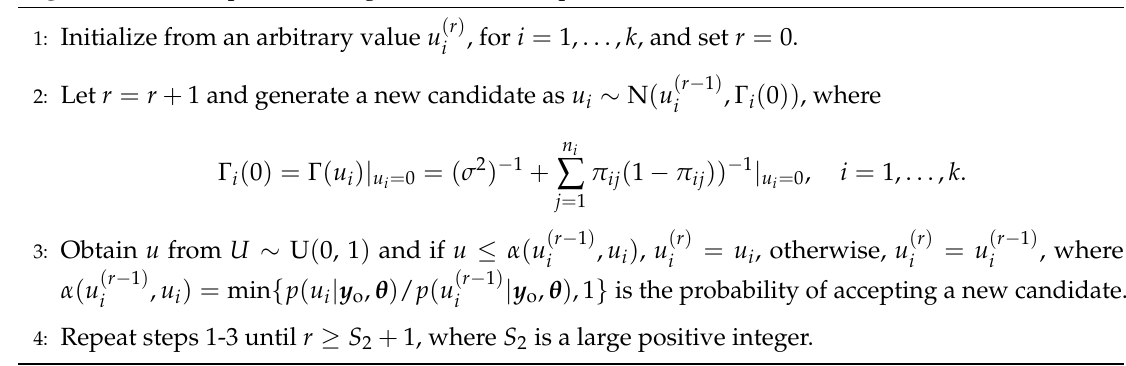
Algorithm 2 Metropolis-Hastings method to sample